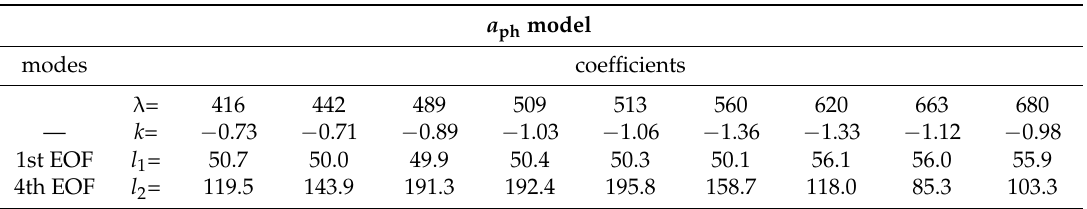
Figure 10. An example of the a ph spectra measured (black), modelled with the fixed number of EOF modes (green), and modelled with EOF modes selected with a stepwise fit (blue) for one data set. Table 7. Selected EOF modes and regression coefficients (4) of the a ph